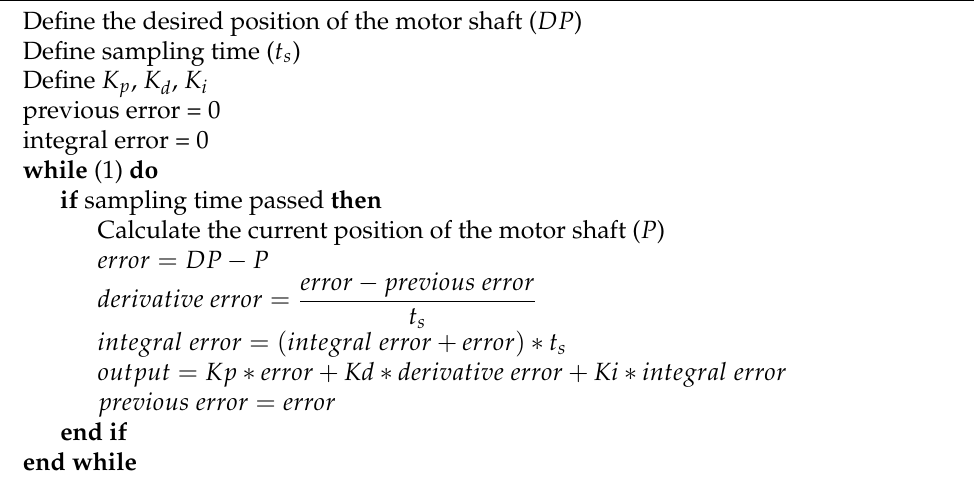
Algorithm 1 PID control pseudocode for motor shaft